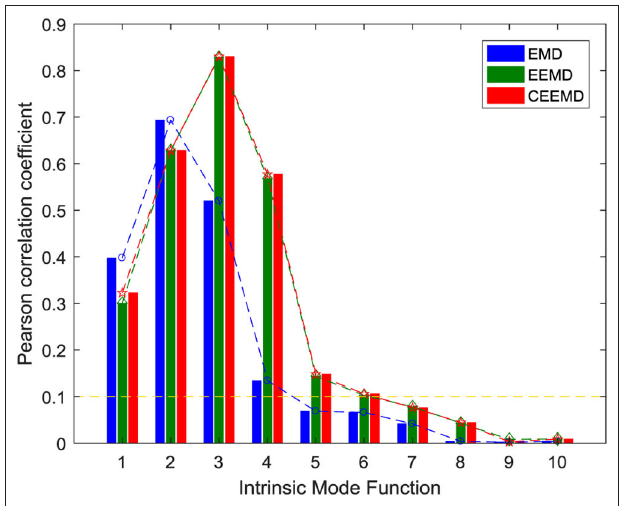
FIGURE 4 | Correlation between IMF components of different channels and raw signals.